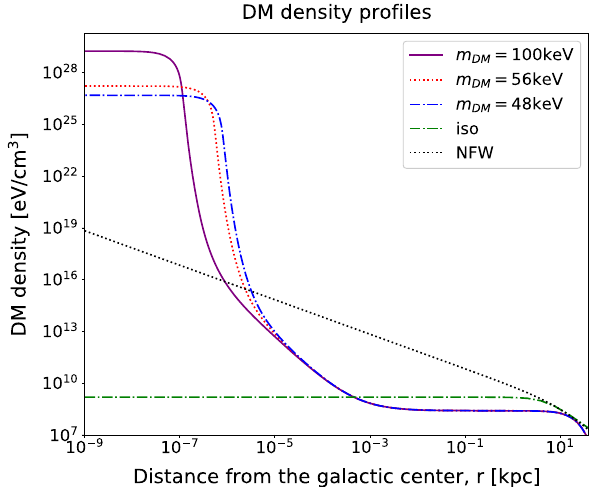
Fig. 1 DM density profiles as a function of the radial distance from the GC. The distributions considered are isotropic (green dashed-dot line, see Eq. 2), Navarro–Frenk–White (black dotted line, see Eq. 1), RAR for m DM = 100 keV (solid line), m DM = 56 keV (red dotted line) and m DM = 48 keV (blue dashed line). We notice that all the distributions are very similar around 10 kpc, where most of the rotation curve data is